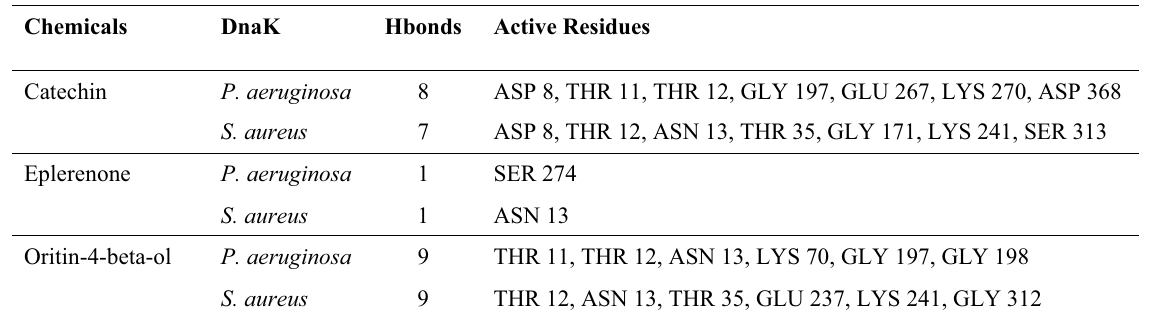
Figure 2. Results of virtual screening targeting P. aeruginosa and S. aureus DnaK proteins. ( A ) Distribution of binding energies plotted via Matplotlib 32 against screened compounds. Top binders with good pharmacological properties, namely ( B ) Catechin, ( C ) Eplerenone, and ( D ) Oritin-4-beta-ol, generated using UCSF ChimeraX 33 . P2Rank predicted binding pockets were colored in green for visualization of ligands (magenta) binding to the receptor DnaK proteins (brown), with active sites (yellow) labelled. ( E ) Intermolecular hydrogen bonds tabulated with active residues